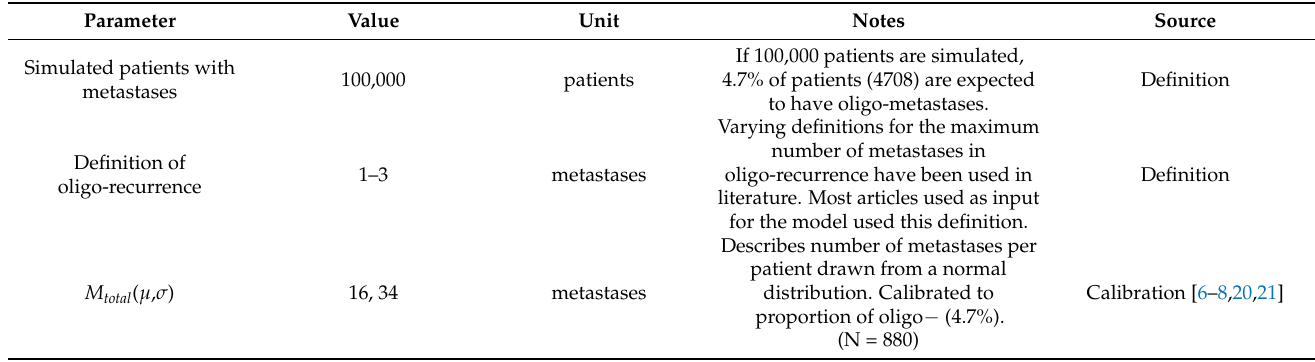
Table 1. Model input